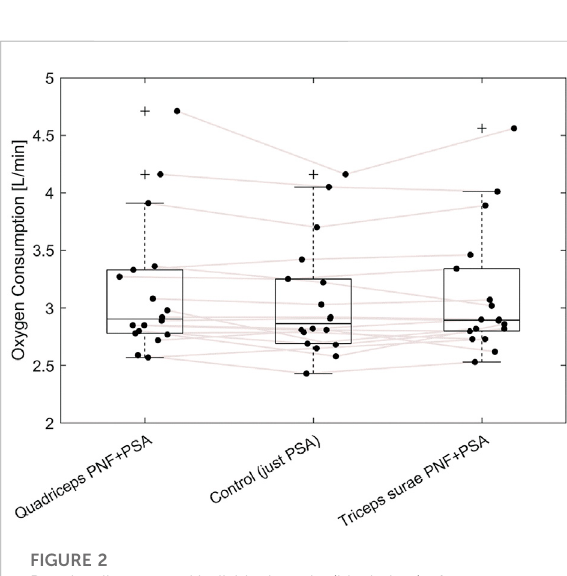
FIGURE 2 Boxplot diagram and individual results (black dots) of oxygen consumption of the three test conditions. PNF, Proprioceptive neuromuscular facilitation; PSA, Post-stretching